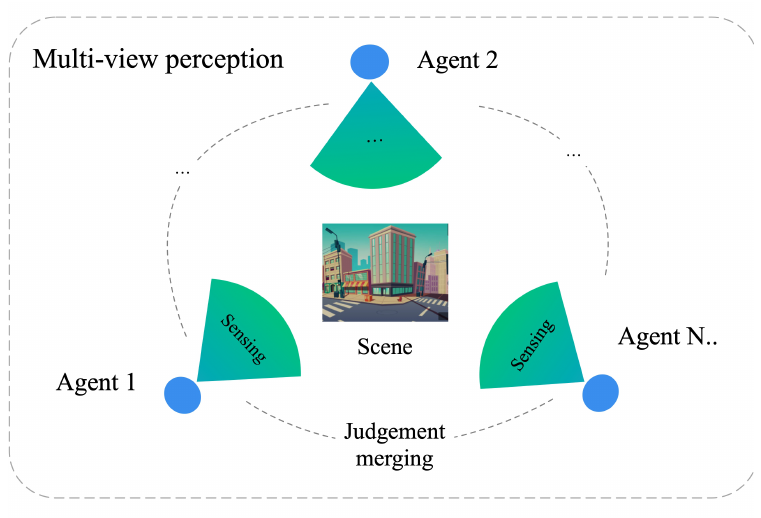
Figure 1. Diagram of multi-view agents collaborative perception and discrimination